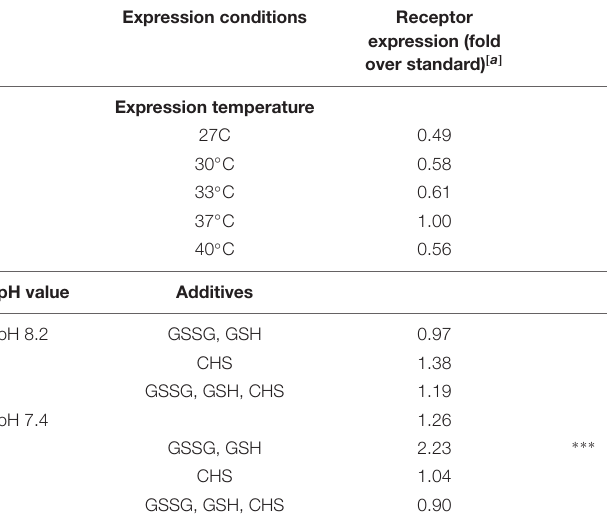
TABLE 2 | Optimization of cell-free Y 2 R_eGFP expression. Expression